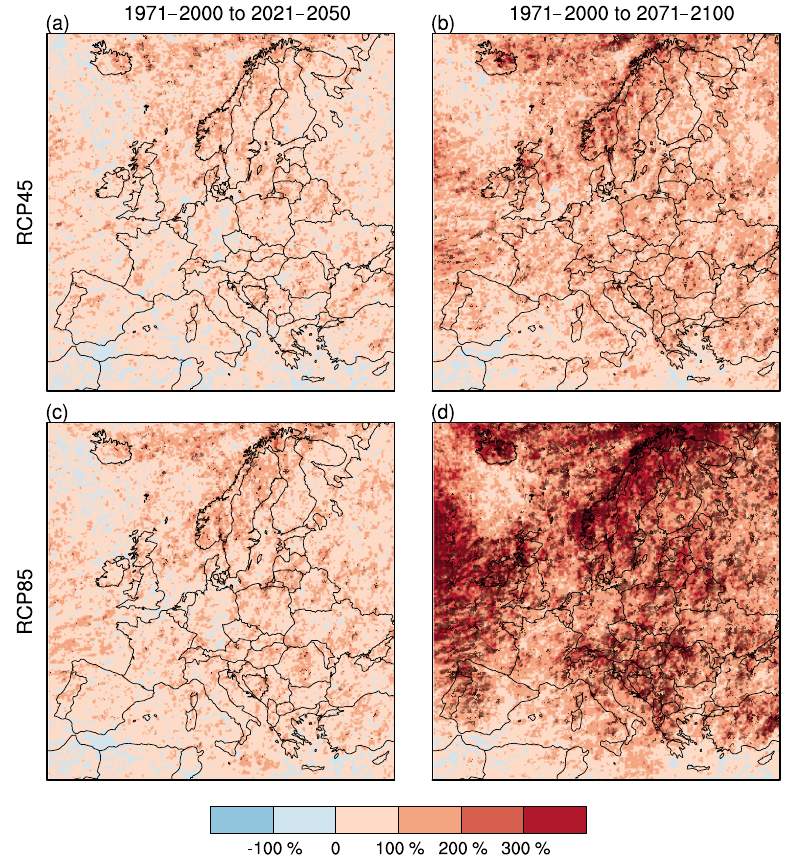
Figure 9. Relative change of probability of events with 10-year return period between the historical simulations (1971–2000) and the scenario simulations ( a 2021–2050 for RCP4.5 scenario, b 2071–2100 for RCP4.5 scenario, c 2021–2050 for RCP8.5 scenario, d 2071–2100 for RCP8.5 scenario). Ensemble mean for sub-daily events. Dots denote statistical significance and inter-model